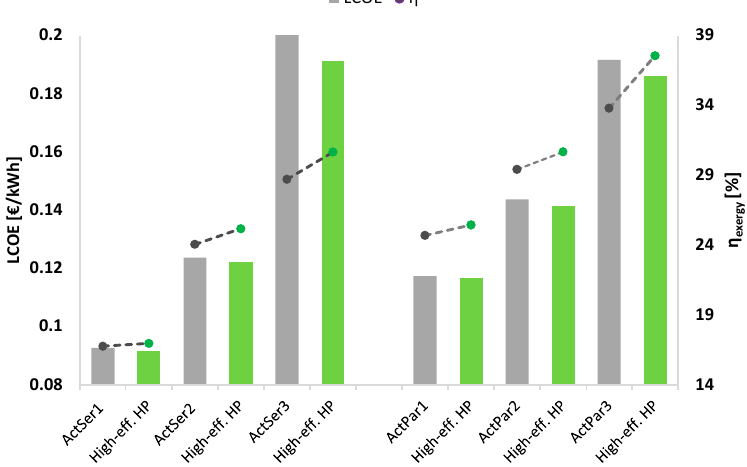
Figure 18. E ff ects of changing HP on LCOE and η exergy on the economical (1), the compromise (2) and Figure 18. Effects of changing HP on LCOE and η (cid:2915)(cid:2934)(cid:2915)(cid:2928)(cid:2917)(cid:2935) on the economical (1), the compromise (2) the most e ffi cient (3) designs of the active and the most efficient (3) designs of the active scenarios.